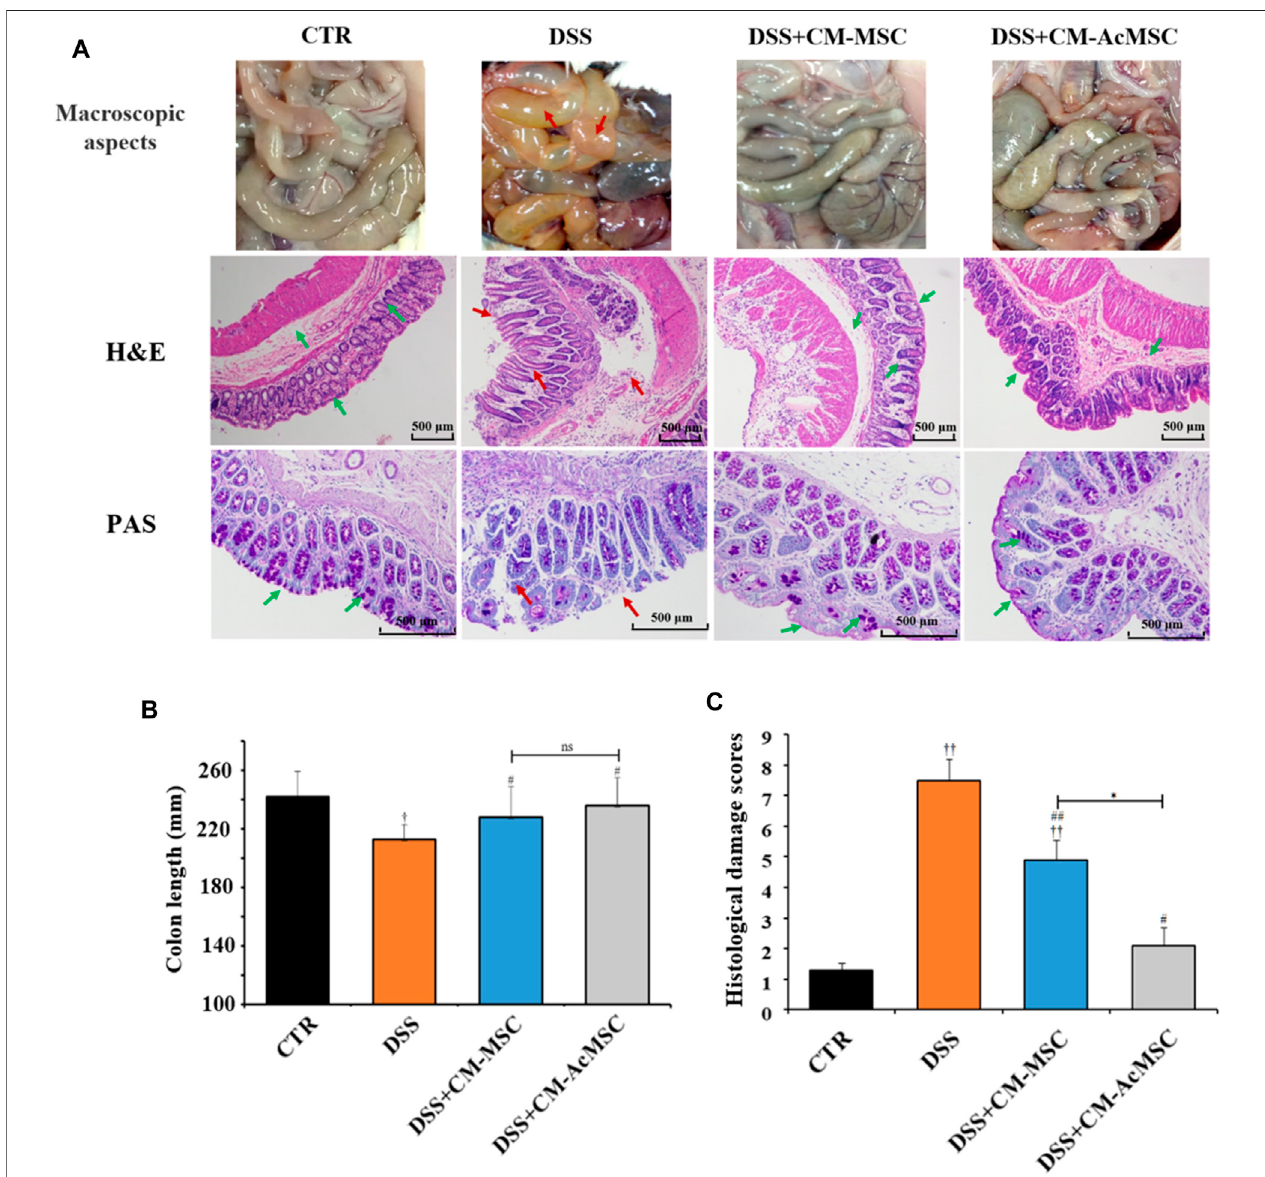
FIGURE 3 | CM-AcMSC signi fi cantly improved colonic histopathological feature in model rats, n (cid:2) 15. (A) Macroscopic aspects of the colon in rats, paraf fi n sectionsofcolontissueswerestainedwithhematoxylinandeosin(H&E),andparaf fi nsectionsofcolontissueswerestainedwithPeriodicAcid-Schiff(PAS),respectively. (B) Thelengthofcolonswasmeasuredpergroup. † p < 0.05, †† p < 0.01 vs CTR; # p < 0.05, ## p < 0.01 vs DSS;* p < 0.05, ** p < 0.01. (C) Histologicaldamagescoreswere evaluated according to scoring criteria